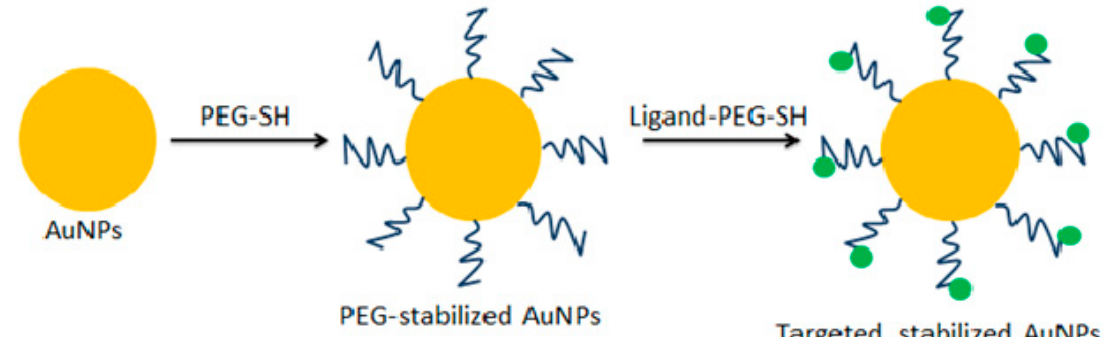
Figure 2. Scheme of the surface functionalization method of Au NPs. Au NPs—yellow circles, PEG-SH—dark blue wavy lines, ligand—green circles (modified from Reference [33]).